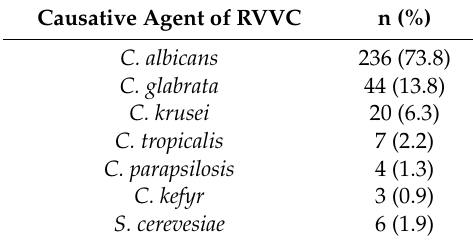
Table 1. Prevalence of recurrent vulvovaginal candidosis (RVVC) caused by Candida spp. and S.